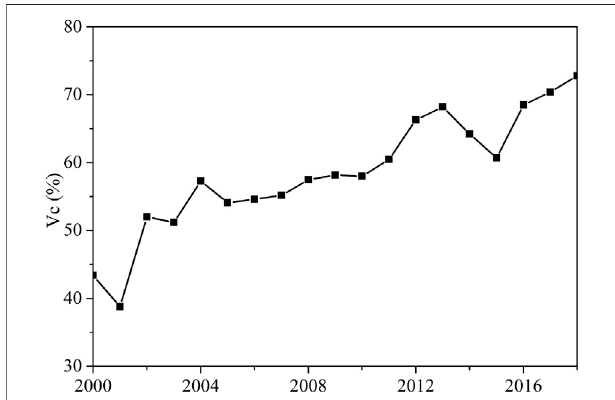
FIGURE 5 | Changes in vegetation coverage in the HLR from 2000 to